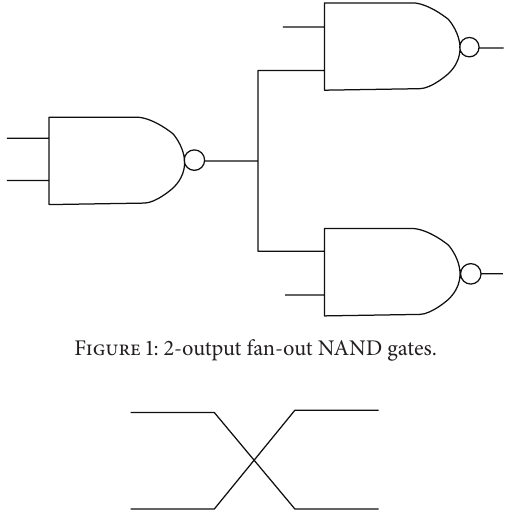
Figure 2: 2-wire swaps [11].